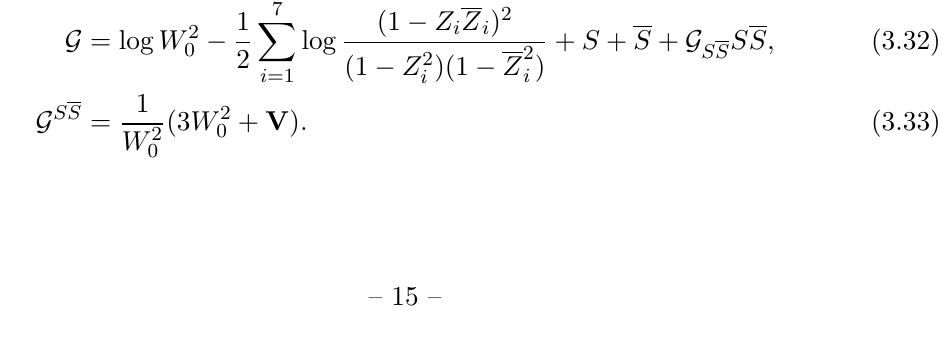
In(cid:13)ation may begin at the upper plateau, with (cid:30) and (cid:30) (cid:29) 1. Then the (cid:12)eld falls down to one of the lower plateaus, from which it moves 2 towards the narrow gorge along (cid:30) falls to the minimum at (cid:30)